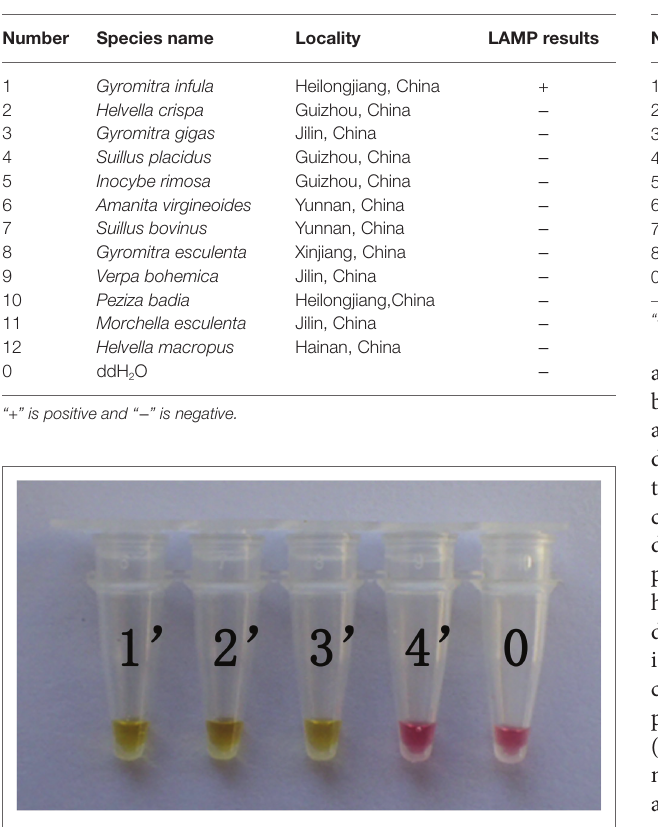
FIGURE 4 | The test results of the LAMP primers set II. The specificity of primer set I was further tested through the control primer set II. The LAMP samples included Gyromitra infula and 3 other non-target species. 1 ' . Gyromitra infula ; 2 ' . Helvella crispa ; 3 ' . Gyromitra gigas ; 4 ' . Suillus placidus ; 0. ddH 2 O.